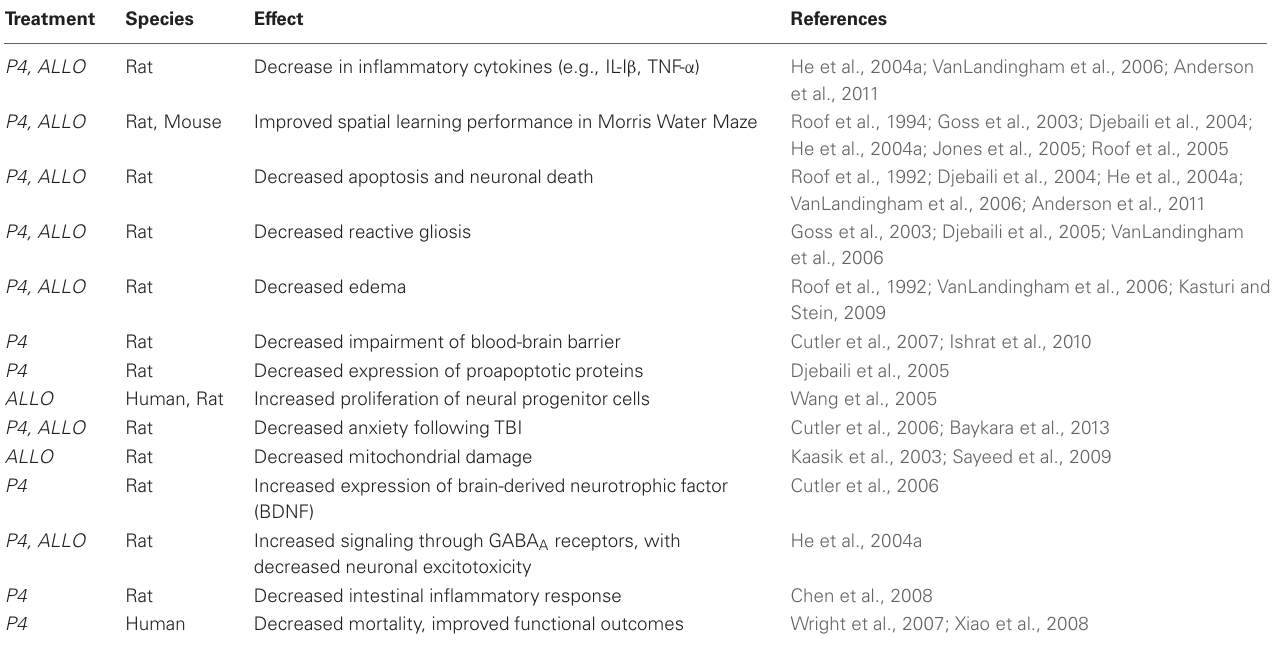
Table 1 | Representative effects of progesterone (P4) and allopregnanolone (ALLO) treatment following traumatic brain injury.